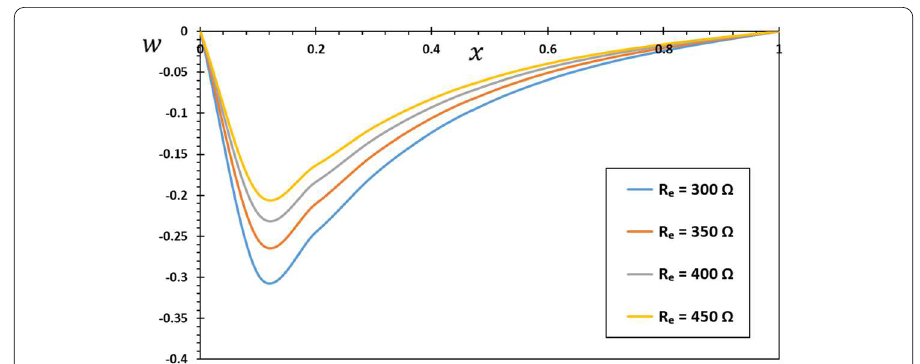
Figure 14 The effect of electric resistance Re on the variation of deflection w